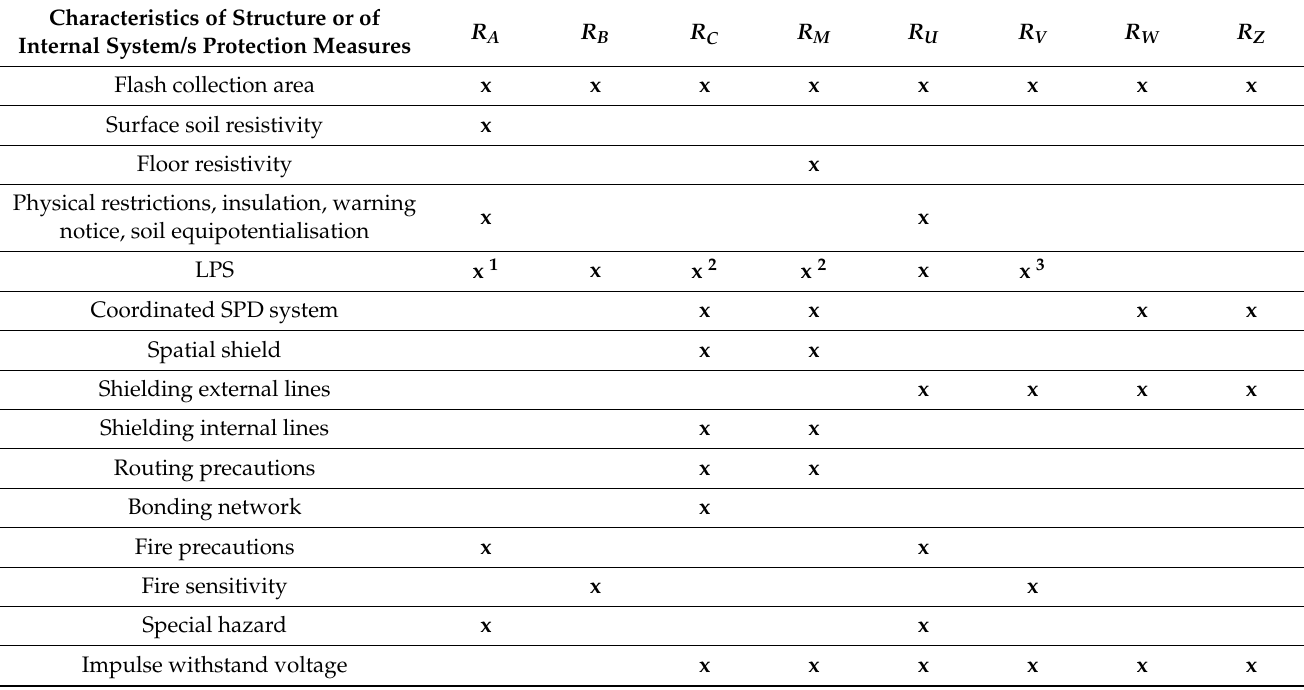
Table 2. Factors influencing the risk components in the structure.